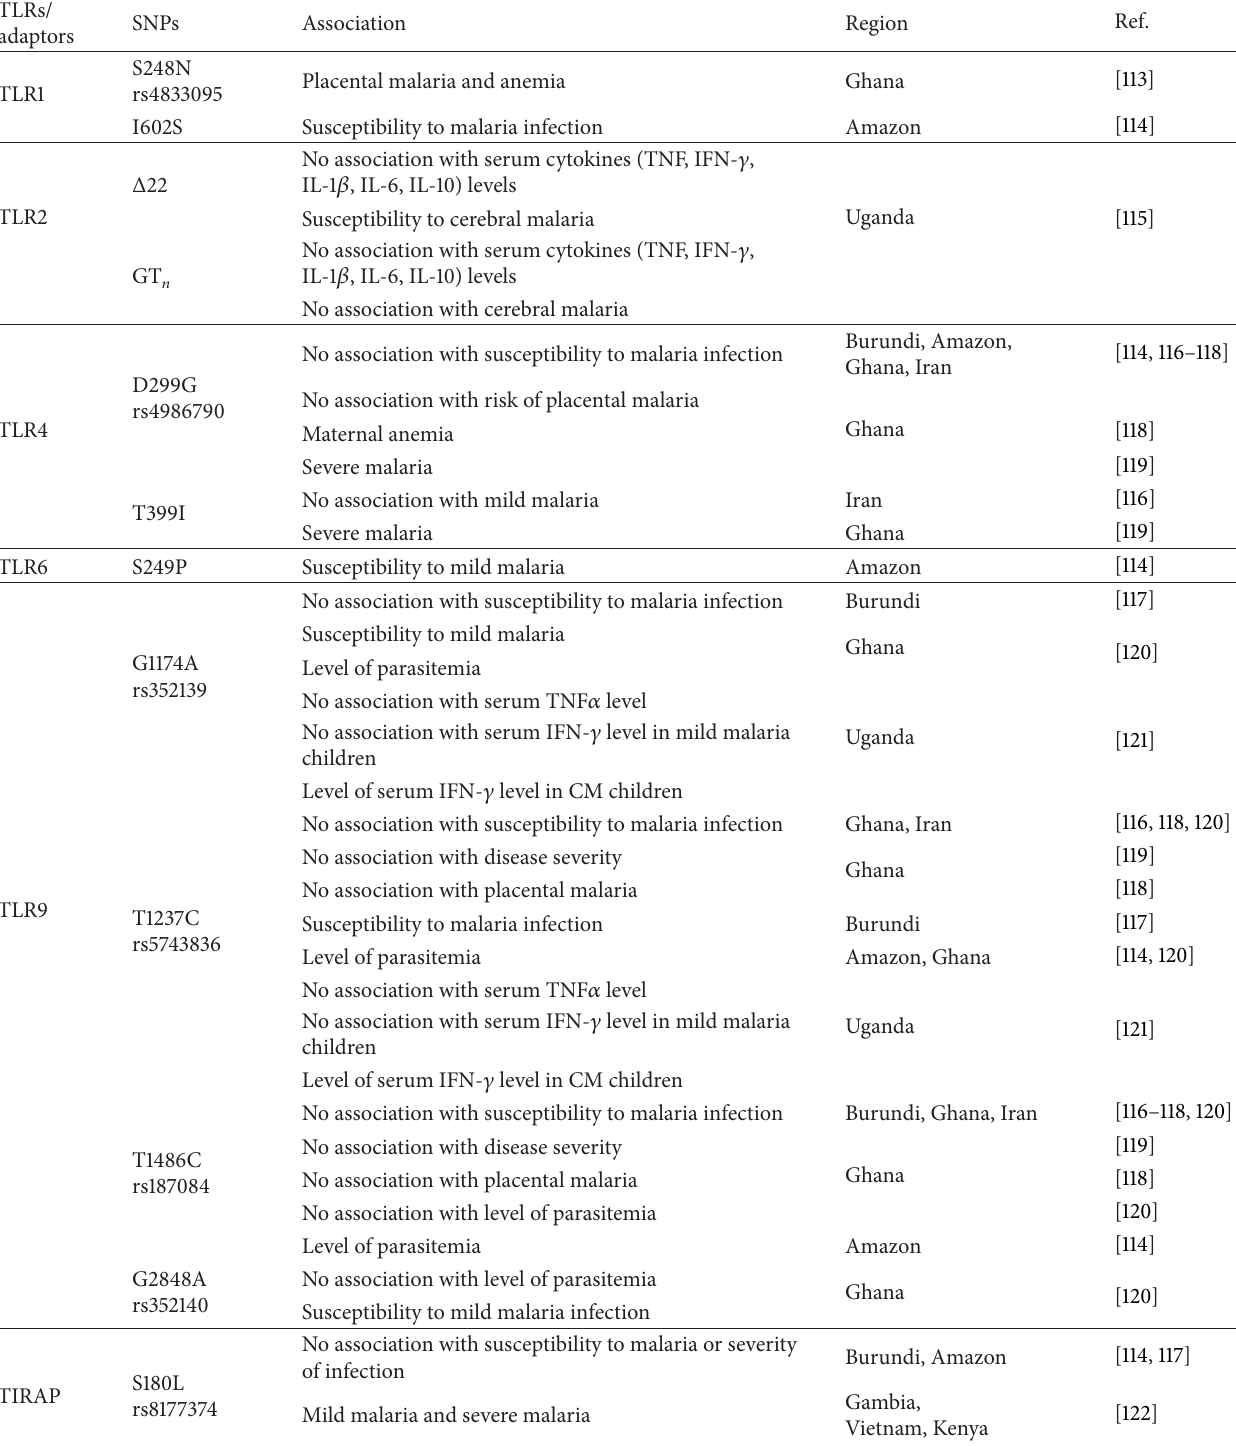
Table 3: Association of TLRs and adaptor molecules gene polymorphisms with susceptibility to malaria or pathology in human. TLRs/ adaptors